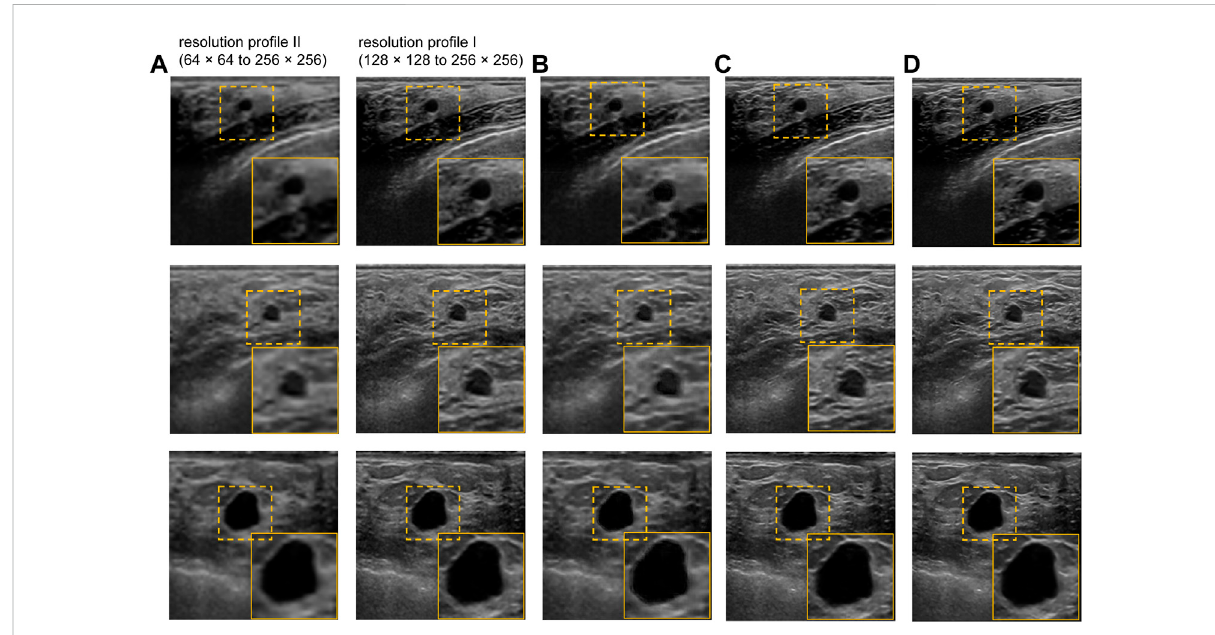
FIGURE 6 Visualresults oftheproposed USimageenhancement modelfortraining oftheproposed network